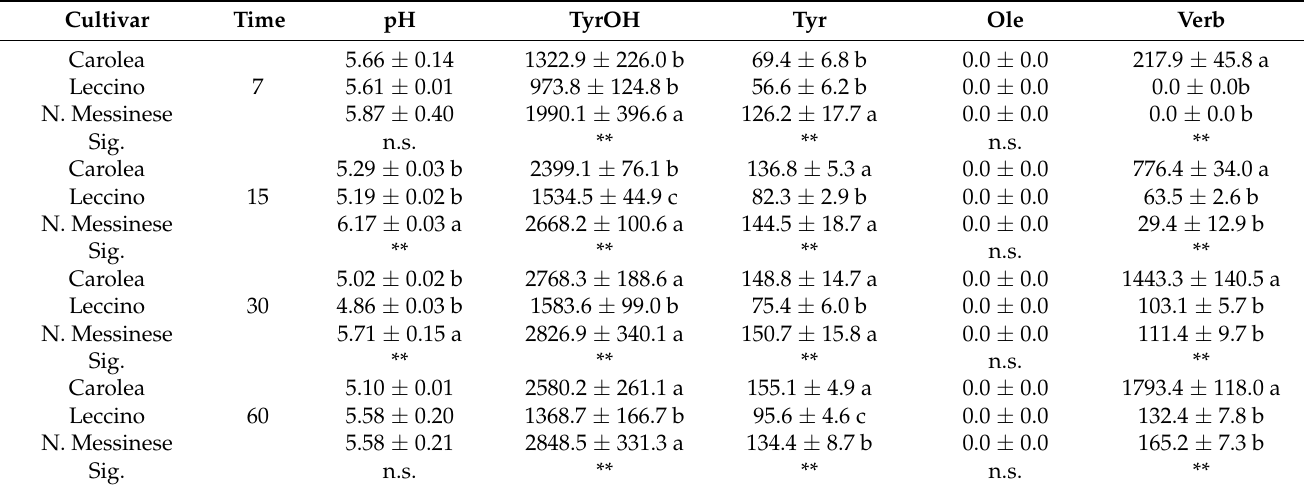
Table 3. Results of pH and single phenolic compounds (mg/L) in the Spanish-style (SS) olive